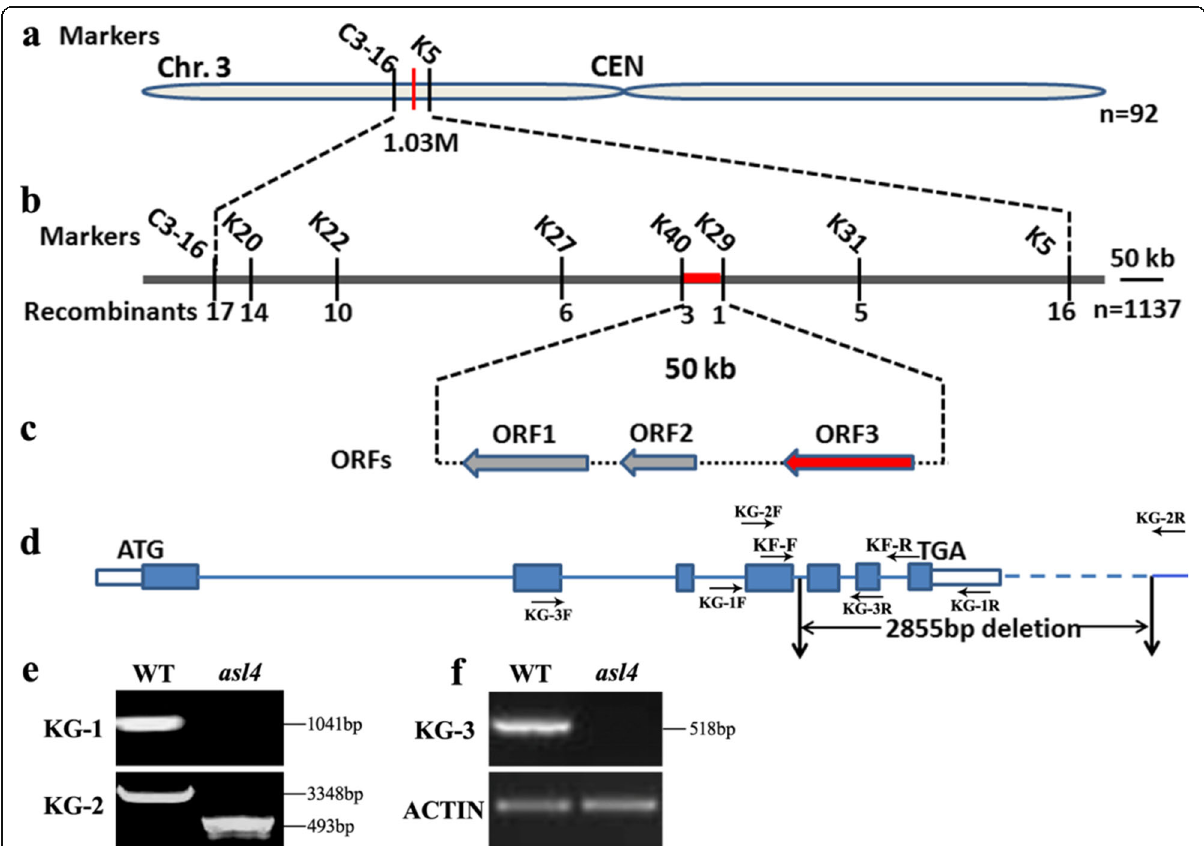
Fig. 2 Map-based cloning of the ASL4 locus. a The ASL4 locus was initially mapped to a 1.03-Mb region between markers C3 – 16 and K5 on the short arm of chromosome 3. b ASL4 was fine-mapped to a 50-kb region between markers K40 and K29 using 1137 F 2 mutant seedlings. c Three ORFs were predicted in the region. d Struct. of ASL4 . ATG and TGA indicate start and stop codons. Blue boxes indicate exons and the lines between them indicate introns. White boxes represent the 5 ′ and 3 ′ UTR. The location of the 2855-bp deletion in the asl4 allele is indicated. PCR identification of genomic DNAs ( e ) and cDNA ( f ) between wild type and asl4 mutant using primer pairs indicated in d . The actin gene was amplified as the